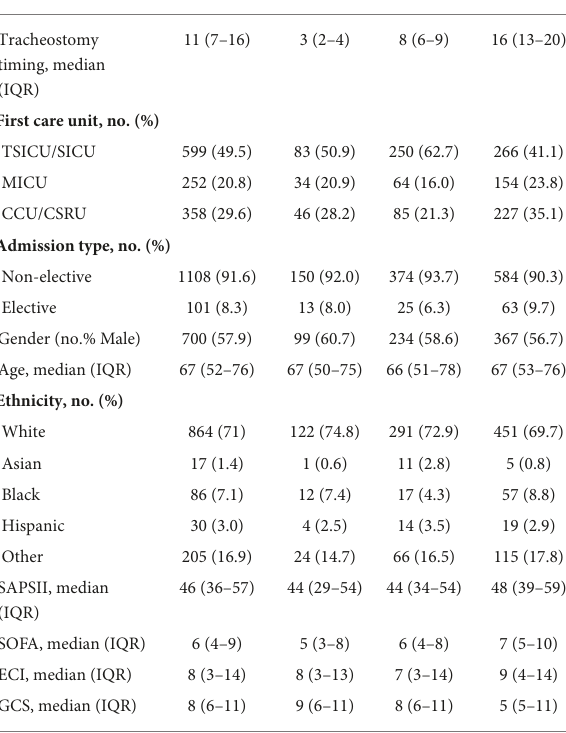
TABLE 3 Univariate and multivariate COX